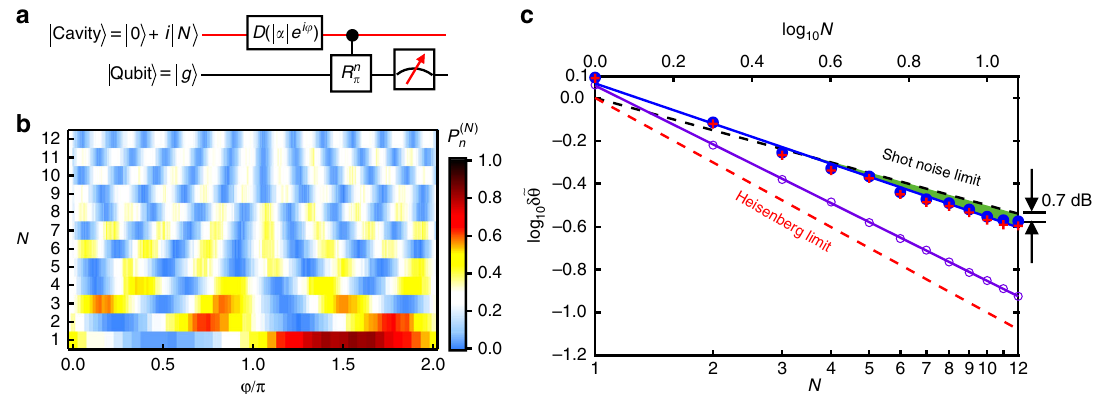
Fig. 4 Hybrid single-mode sensing scheme. a Quantum circuit. The initial state |0 〉 + i | N 〉 corresponds to an arbitrarily chosen phase θ = π /2 N to demonstrate the idea of the phase estimation. The detection is realized by a combination of a displacement of the photonic mode [ D ( α = | α |e i φ )] and selective photon number (| n 〉 state) detection enabled by the ancillary qubit through its dispersive interaction to photons. b The measured probability P ð N Þ n of projecting to the photon number state | n opt 〉 as a function of φ in the displacement operation, with the optimal n opt for each N being numerically obtained. c Quantum advantage for the hybrid scheme. Blue dots are experimental results. The blue solid line is a linear fi t and gives ~ θ ¼ (cid:3) 0 : 62 log 10 δ log 10 N þ 0 : 068. The red crosses are the results from numerical simulations including the decoherences of our system, in good agreement with the measured data. Green region represents the experimental results that surpass the standard limit by about 0.7 dB at N = 12. Purple δ ~ θ ¼ (cid:3) 0 : 91 log N þ 0 : 057, provided all photon numbers can be circles show the achievable precision for the hybrid sensing scheme with a fi t log 10 10 detected. The error bars, obtained through the standard deviations of A ð N Þ n and B ð N Þ n in fi tting the data in b , are smaller than marker sizes. The scaling N − 0.62 ( N − 0.69 for an ideal experiment) can still beat the standard scaling N − 0.5 due to the initial MVS. The offset of the hybrid scheme is mainly due to